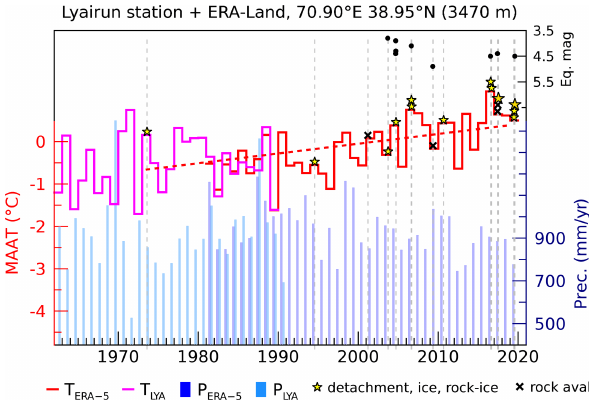
Figure 9. Mean annual air temperature (MAAT) of ERA-5 Land reanalysis data obtained for 3470ma.s.l. (red). The MAAT of the Lyairun station at 2008ma.s.l. (magenta) was shifted to match the ERA data. The dashed red line indicates the temperature trend. De- tachments and ice and rock-ice avalanches are indicated by (cid:63) sym- bols and rock avalanches by + symbols. Symbols are vertically stacked when more than one event occurred in the same year. The magnitude of seismic events that occurred between the pre- and post event image (Table 4) and that are within the range indicated by the dotted line in Fig. 10 are indicated by black dots. Figure contains modified Copernicus Climate Change Service Information (2020); earthquake data from USGS via IRIS Data